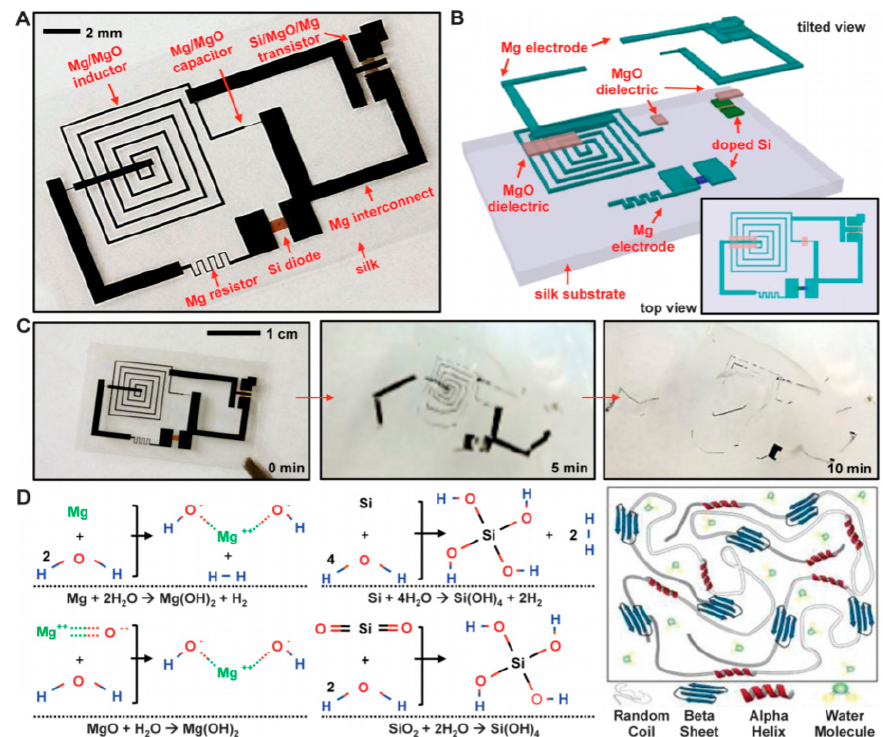
Figure 7. Transient electronics featuring tracks, resistor, inductor, capacitor, diode and transistor, printed on a silk substrate. ( A ) Optical image of a device. ( B ) Exploded view showing the different layers (inset: top view). ( C ) Time sequence of dissolution of the whole device in water. ( D ) Details of the chemical reactions with water for each of the constituents. Reprinted from [62] with permission from AAAS.